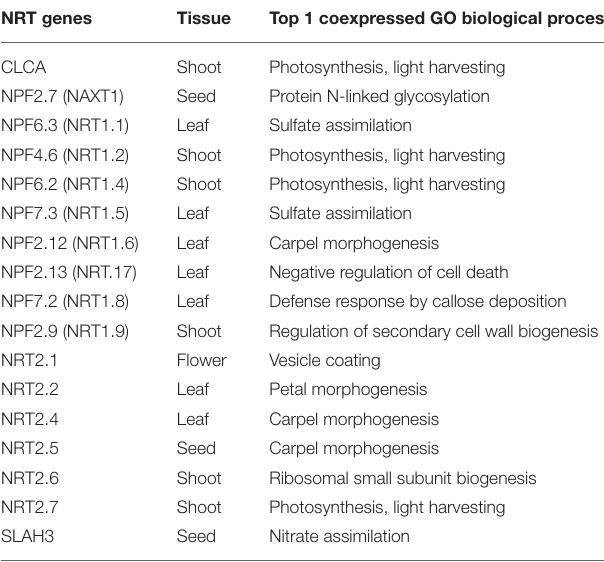
TABLE 2 | The top1 correlated pathways for each of 17 N